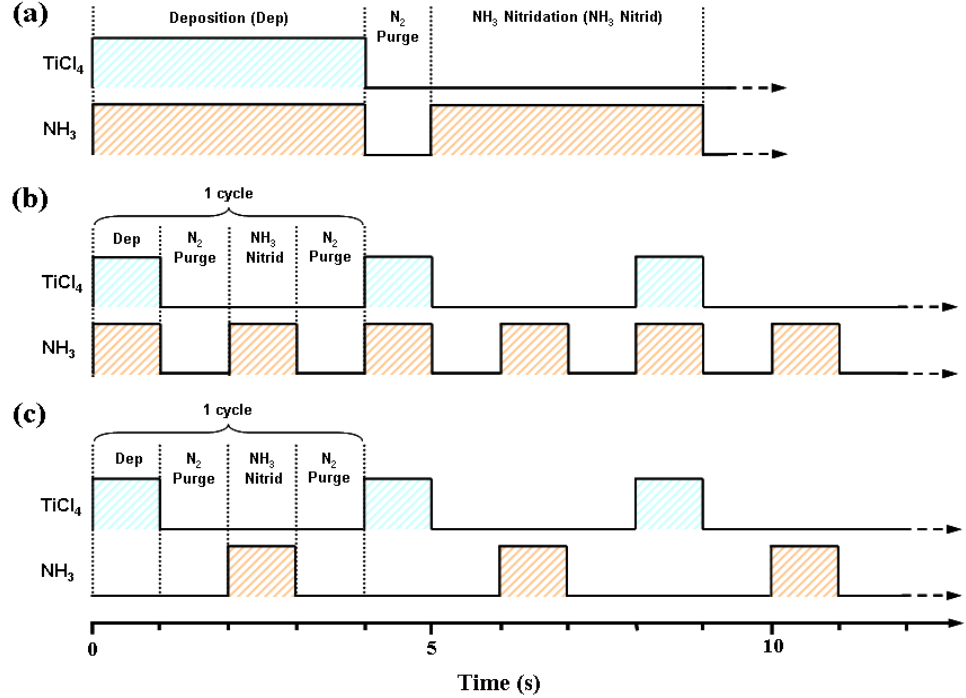
Figure 6. Schematic diagrams of the precursor flow steps of ( a ) conventional HSC; ( b ) SFD; ( c ) ALD TiN deposition methodologies.